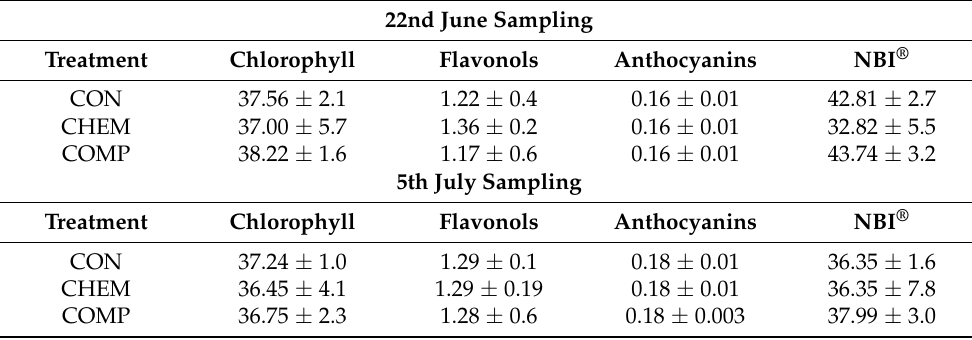
Table 2. Results of mean value and standard deviation of leaf samplings. Values with differ- ent letters indicate mean values significantly different according to the Tukey’s post hoc test per- formed on results of ANOVA with p -value < 0.05, conducted within each sampling. CON = Control; CHEM = chemical fertilizer; COMP =